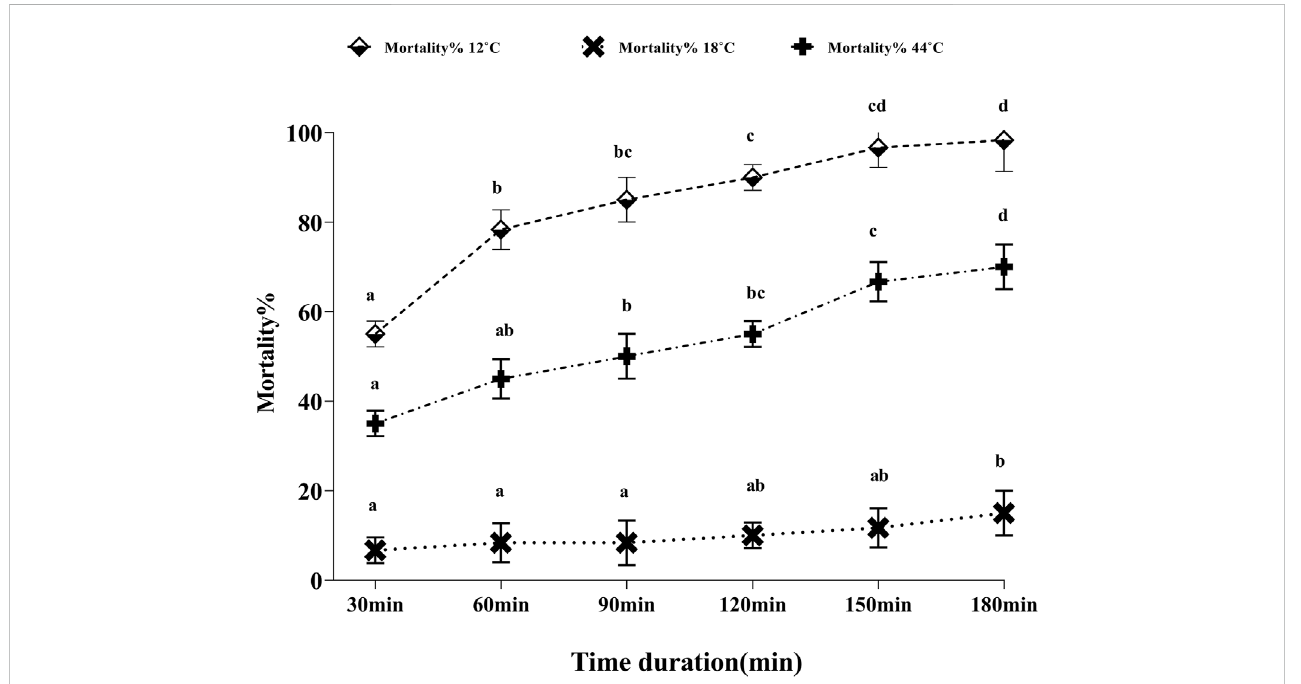
Percentage mortality of white fl y adults in response to thermal stress (12 ° C, 18 ° C, and 44 ° C). White fl y adults from each treatment were incubated for 30, 60, 90, 120, 150, and 180 min in three replicates, and the mortality rates were measured after each incubation